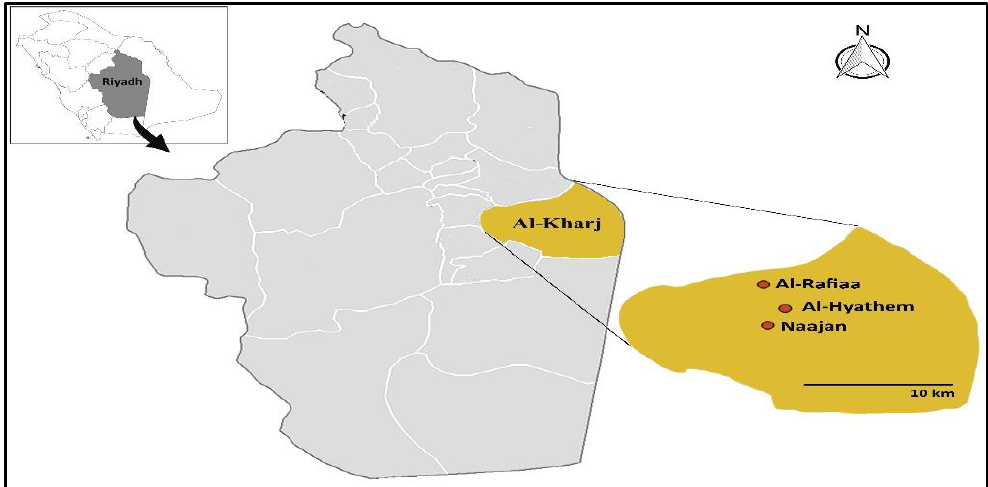
Figure 1. Map of the study area showing the selected districts.